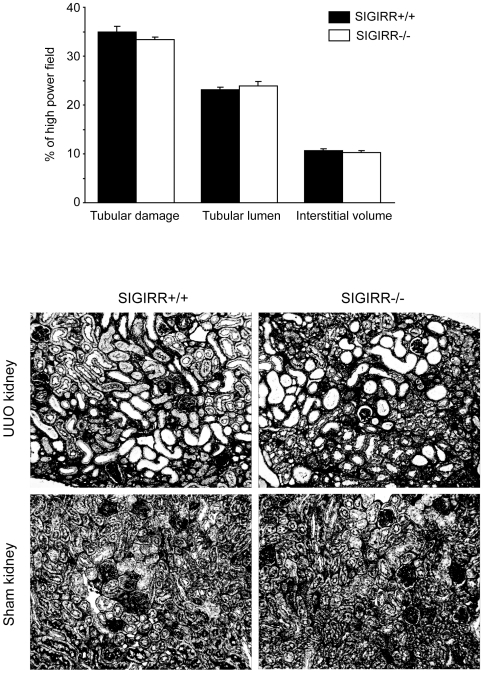
SIGIRR and morphometric analysis of tubulointerstitial pathology after UUO.Cortical renal sections were stained with silver. Images illustrate representative sections of UUO and sham-operated kidneys 10 days after UUO in mice of the respective group as indicated (original magnification 200×). The indices for interstitial volume, tubular damage, and tubular lumen were determined in UUO kidneys from wildtype (black bars) and Sigirr-deficient mice (white bars) by quantitative morphometry as decribed in the methods section. Values represent means ± SD from 10 high power fields of UUO kidneys from 10 mice in each group.